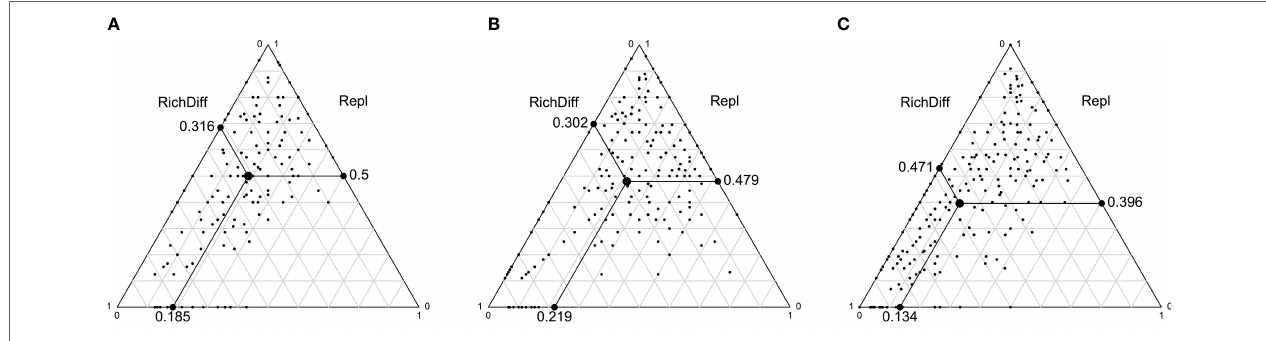
FIGURE 4 | Triangle plots of all pairs of sites in the PRE demersal fish data set for the three surveys, based on the Podani indices of richness, abundance difference, replacement and corresponding similarities. The larger black dots in each plot is the mean values of the indices, as well as the position of a “mean pair of sites”. RichDiff is the richness difference. Repl is the replacement.